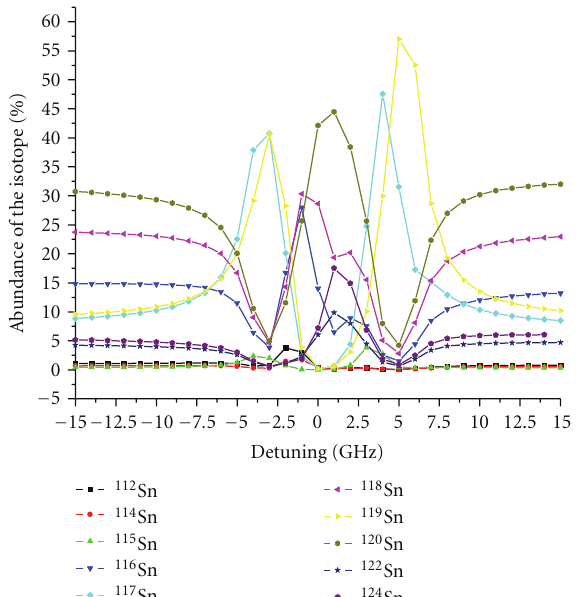
Figure 7: Experimental abundance of the tin isotopes as a function of laser detuning for 286.3317nm transition for a laser linewidth of 2400MHz and a residual Doppler width of 400MHz.